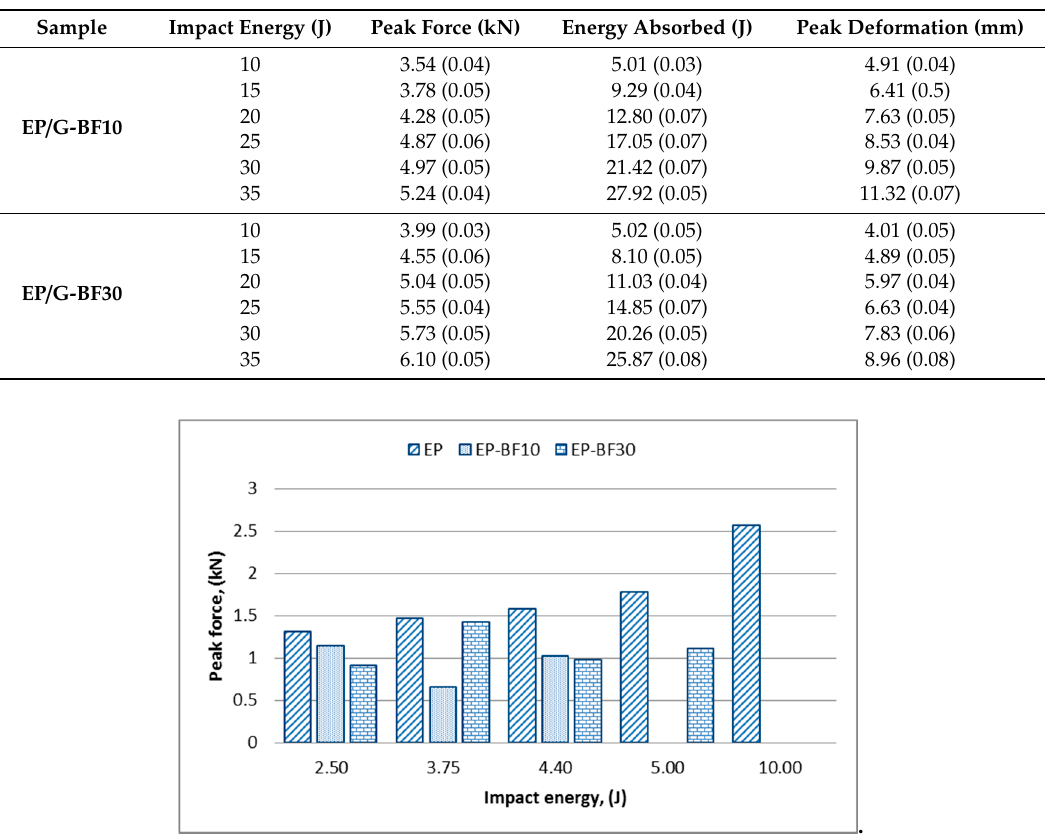
Table 4. Data analysed from the force displacement graphs of EP / G-BF10 and EP / G-BF30 at the second range of the impact energy level.